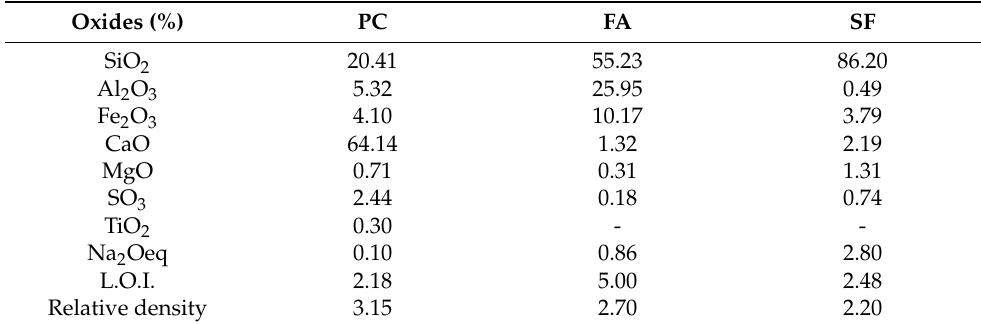
Table 1. Physicochemical properties of PC and SCMs.